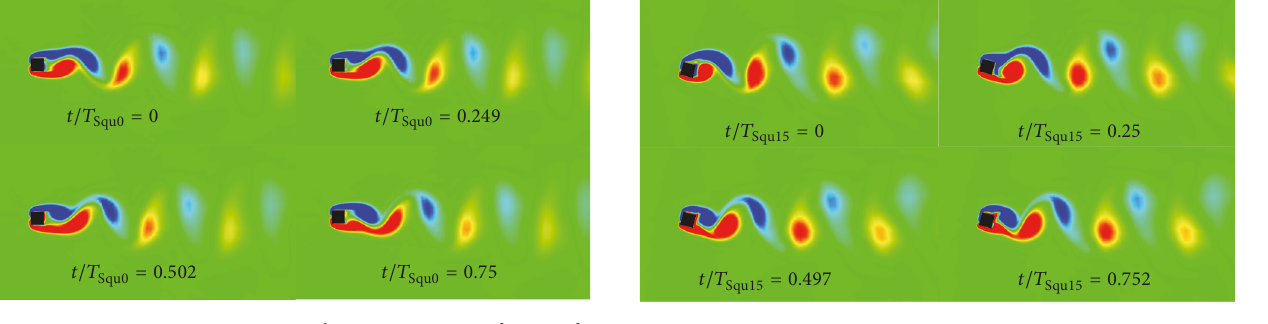
The results of the maximum output power of square column VIVPEH under different attack angles are given in Figure 22. It can also be seen that the maximum value of the output power appears at the case of 𝛼 = 45 ∘ and